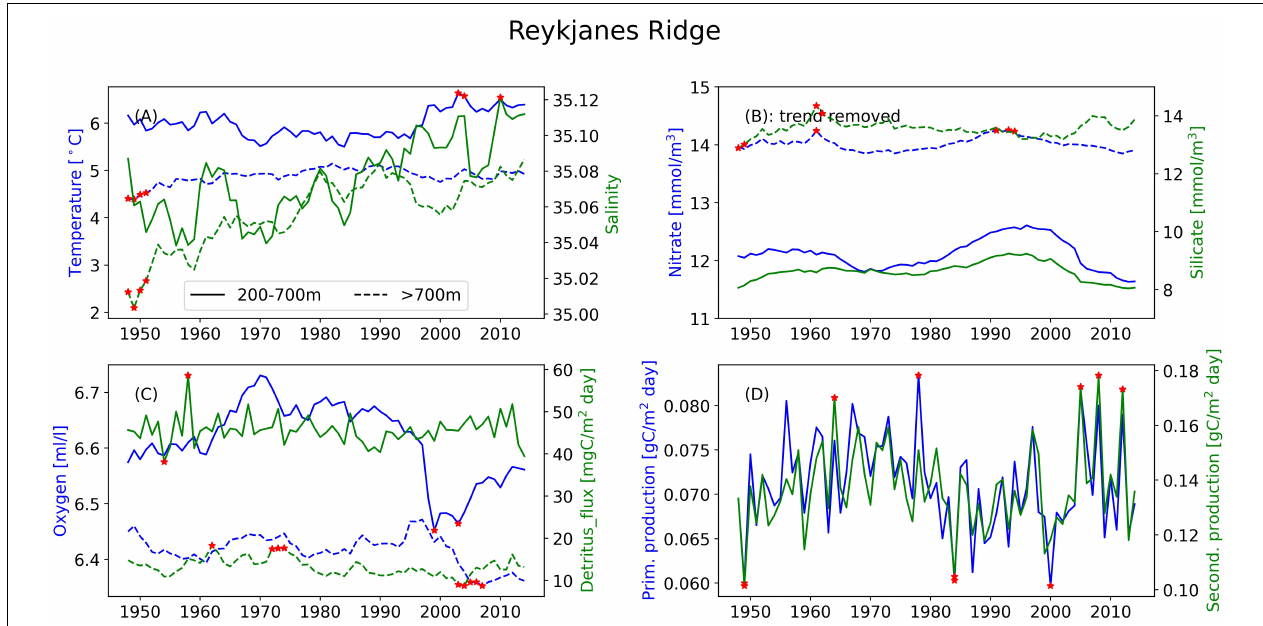
FIGURE 5 | Timeseries of the annual mean of different variables illustrating the interannual variability at the Reykjanes Ridge for (A) temperature (blue) and salinity (green), (B) nitrate (blue) and silicate (green), and (C) oxygen (blue) and detritus (green). Solid lines are areas with bottom depth between 200 and 700 m, dashed lines are areas deeper than 700 m. (D) Depth-integrated primary production (blue) and secondary production (green) from the full area. Red stars indicate years when values are outside two standard deviations of the temporal mean.